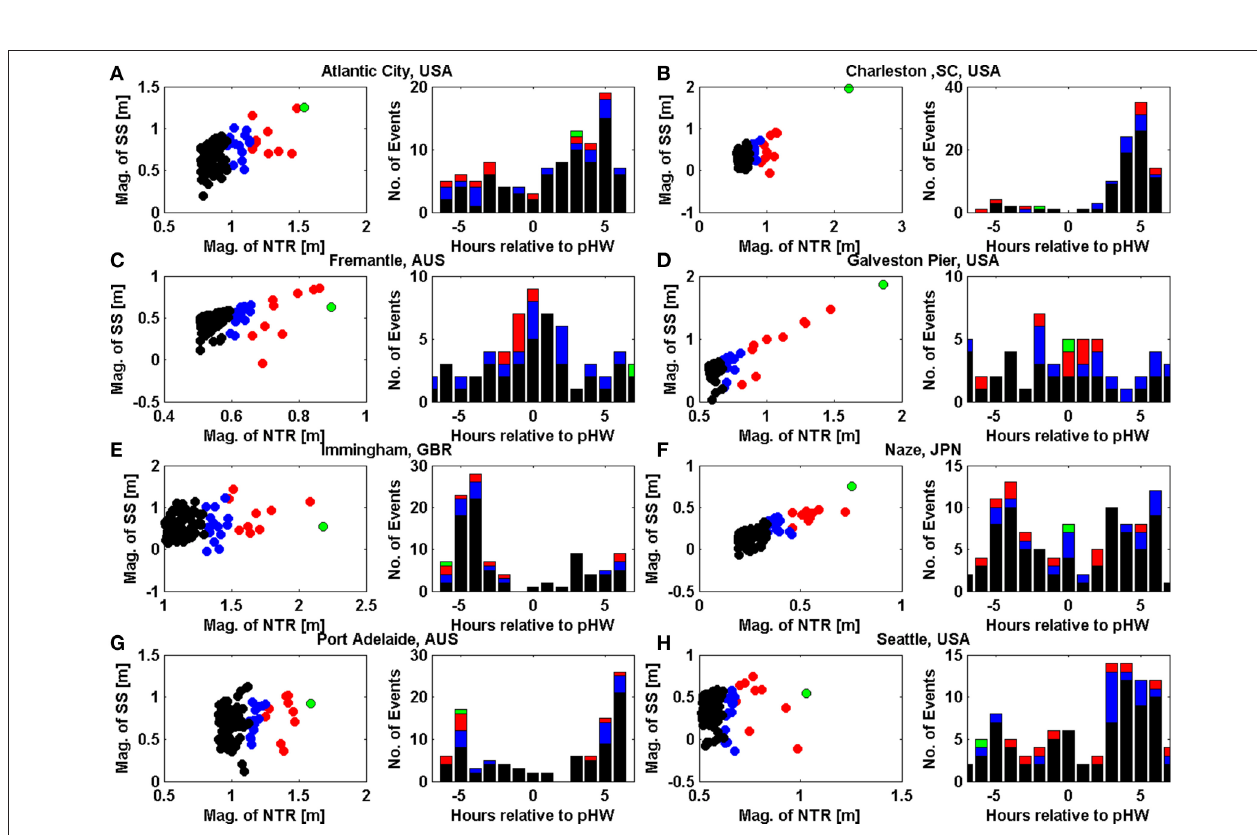
FIGURE 4 | For eight selected sites: (A) Atlantic City, USA; (B) Charleston, USA; (C) Fremantle, Australia; (D) Galveston, USA; (E) Immingham, UK; (F) Naze, Japan; (G) Port Adelaide, Australia; (H) Seattle, USA. Left, scatter plot of 200 largest NTR and the associated skew surge value, right histogram of the time of the peak NTR relative to predicted high water. Both plots are cultured according to magnitude with green showing the maximum NTR, red the top 10 NTR and blue the top 25 NTR, black are the remainder of the top 200 NTR.